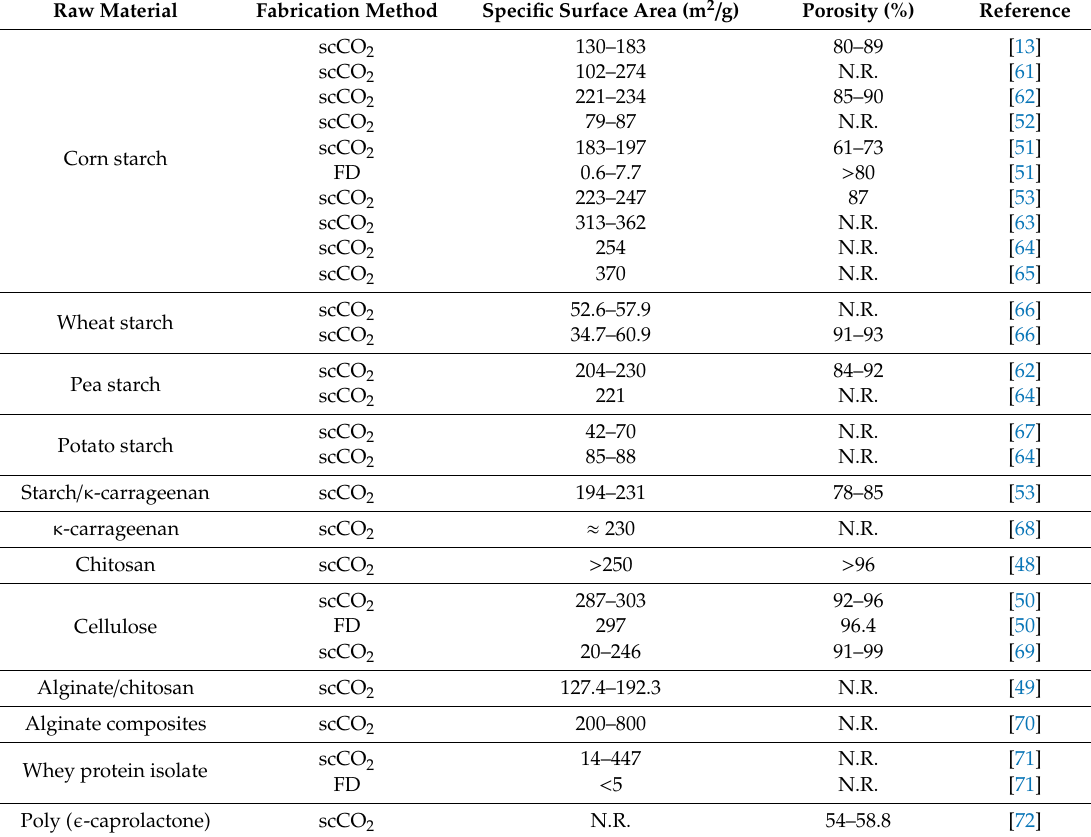
Table 1. Properties reported in di ff erent research studies for porous materials from